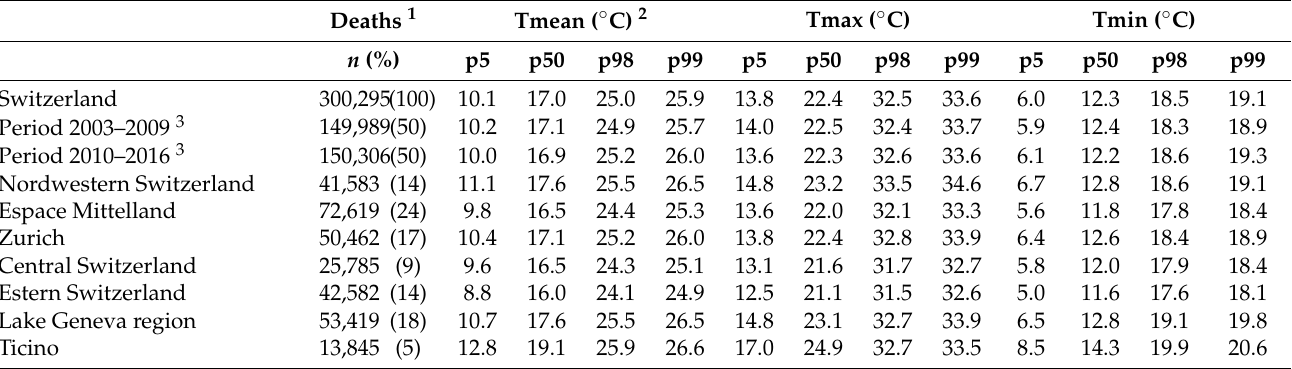
Table 1. Description of the number of deaths (by region and time period) and ambient daily mean temperature (Tmean), daily maximum temperature (Tmax), and daily minimum temperature (Tmin) on days of death and control event days during the warm season of